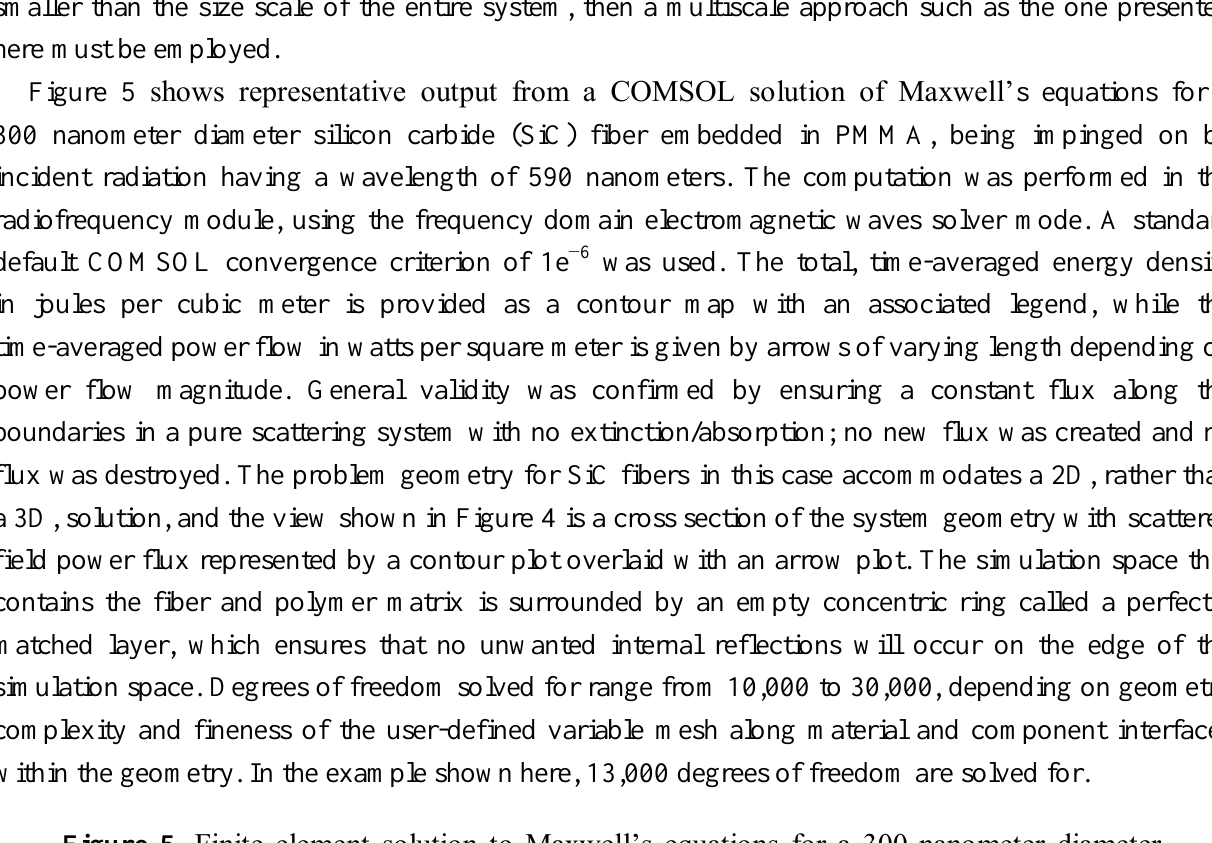
Figure 5. Finite element solution to Maxwell’s equations for a 300 nanometer diameter SiC fiber embedded in PMMA matrix. This representative output shows the scattered field power flux as both contour and arrow plots. The length scale of the x and y axes is given in